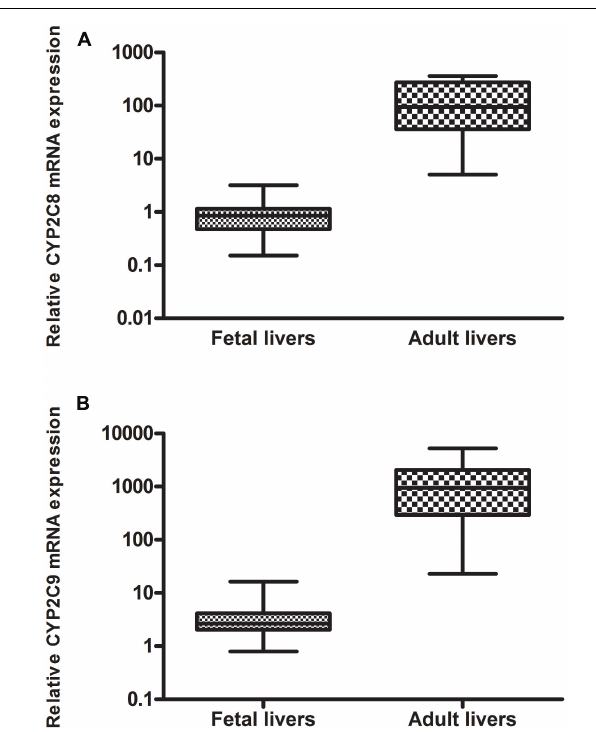
FIGURE 1 | Relative mRNA expression of (A) CYP2C8 and (B) CYP2C9 in liver from human fetuses ( n = 60) and adults ( n = 20): Significantly higher levels (143 times) of (A) CYP2C8 were observed in the adult liver samples, p < 0.0001 and significantly higher levels (396 times) of (B) CYP2C9 were observed in the adult liver sample, p < 0.0001.